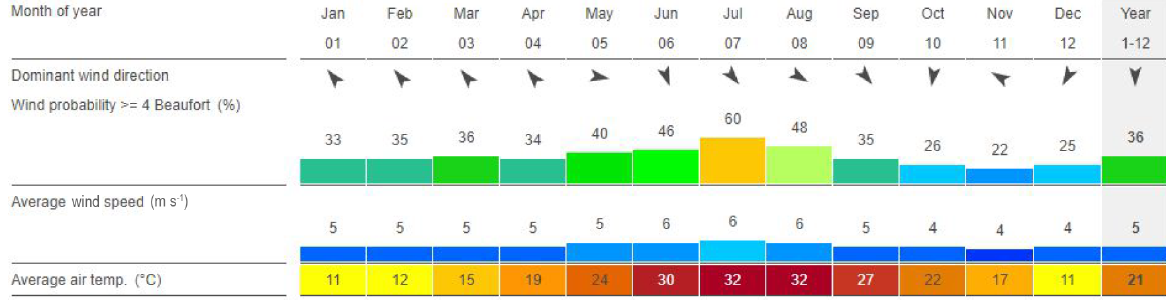
Figure 3. Monthly and yearly wind direction and average wind intensity from 2000 up to the present for the ˙Izmir Bay environment. The arrows point in the direction that the wind is blowing. The last column indicates the dominant wind and its intensity (https://www.windfinder. com).